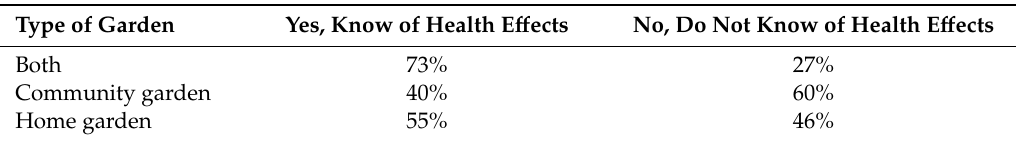
Table 5. Knowledge of participants regarding potential health e ff ects of slag, lead, and / or arsenic in soil based on the type of garden they participated in. Type of Garden Yes, Know of Health E ff ects No, Do Not Know of Health E ff ects Both 73% 27% Community garden 40% 60% Home garden 55% 46% Total question respondents: